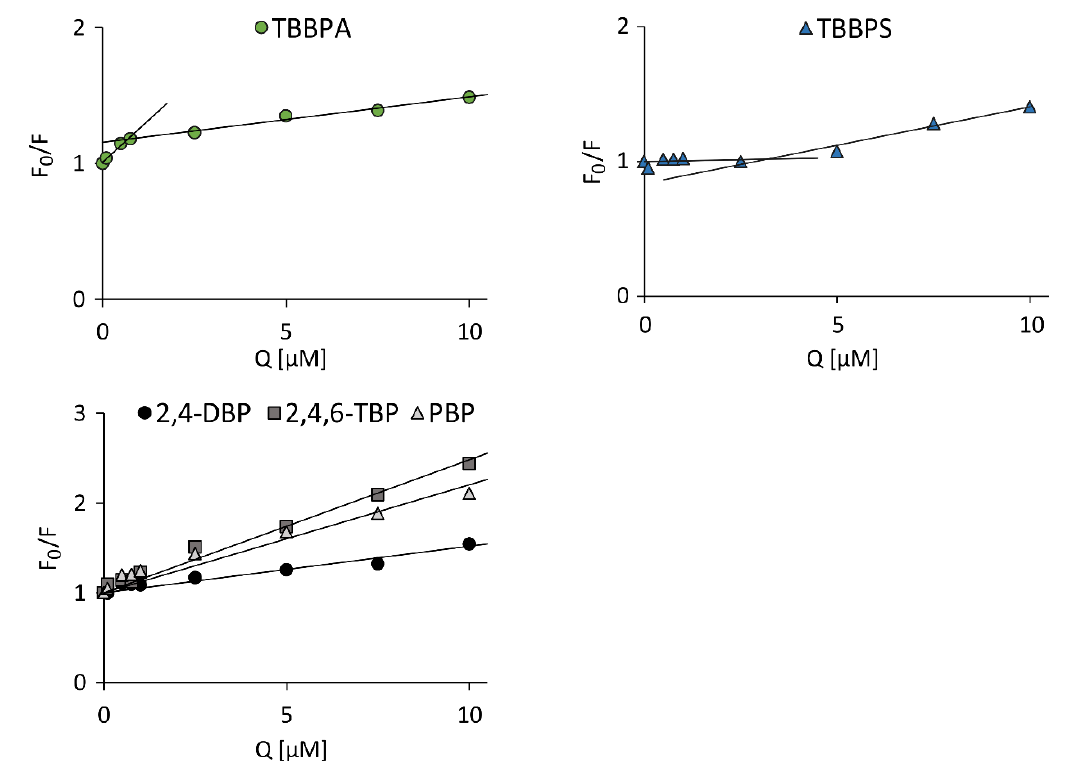
Figure 2. Stern–Volmer plots for HSA-tryptophan fluorescence quenching by analyzed BFRs. Table 1. Quenching constants of HSA and selected BFRs at 21 ºC, over the concentration range of